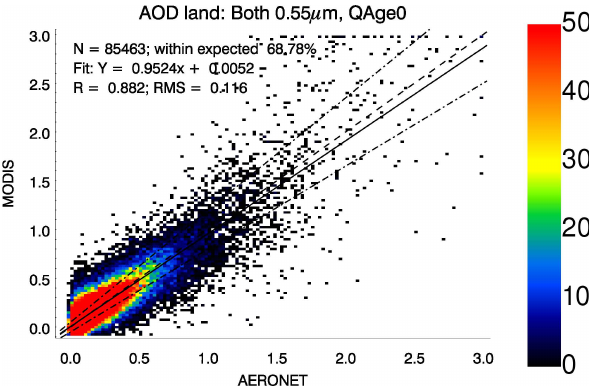
Fig. 1. MODIS C005 AOD at 0.55µm over dark land (QAC ≥ 0) collocated with AERONET (quadratically interpolated) to the same wavelength, for both (the union of) Terra and Aqua datasets. Data are sorted according to ordered pairs (AERONET, MODIS) of AOD in 0.025 intervals, so that color represents the number of cases (color bar) having that particular ordered pair value. The dashed, dotted and solid lines are the 1-1 line, EE for land AOD ± (0.05+0.15), and the linear regression of the pre-sorted scatter- plot, respectively. Text at the top describes: the number of colloca- tions (N) , the percent within expected error, the regression curve, correlation ( R) , and the RMS error of the fit. Note that each axis ranges from − 0.1 to 3.0, to show allowed negative